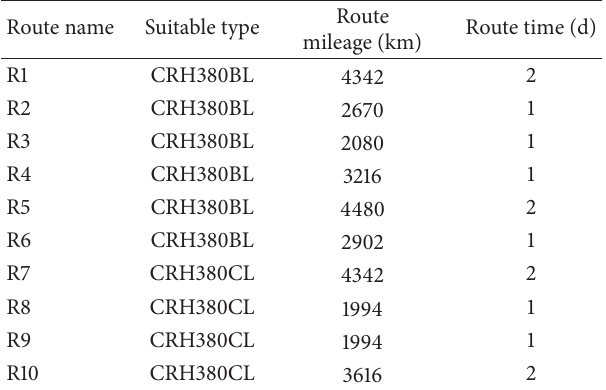
Table 1: Basic information of routes.